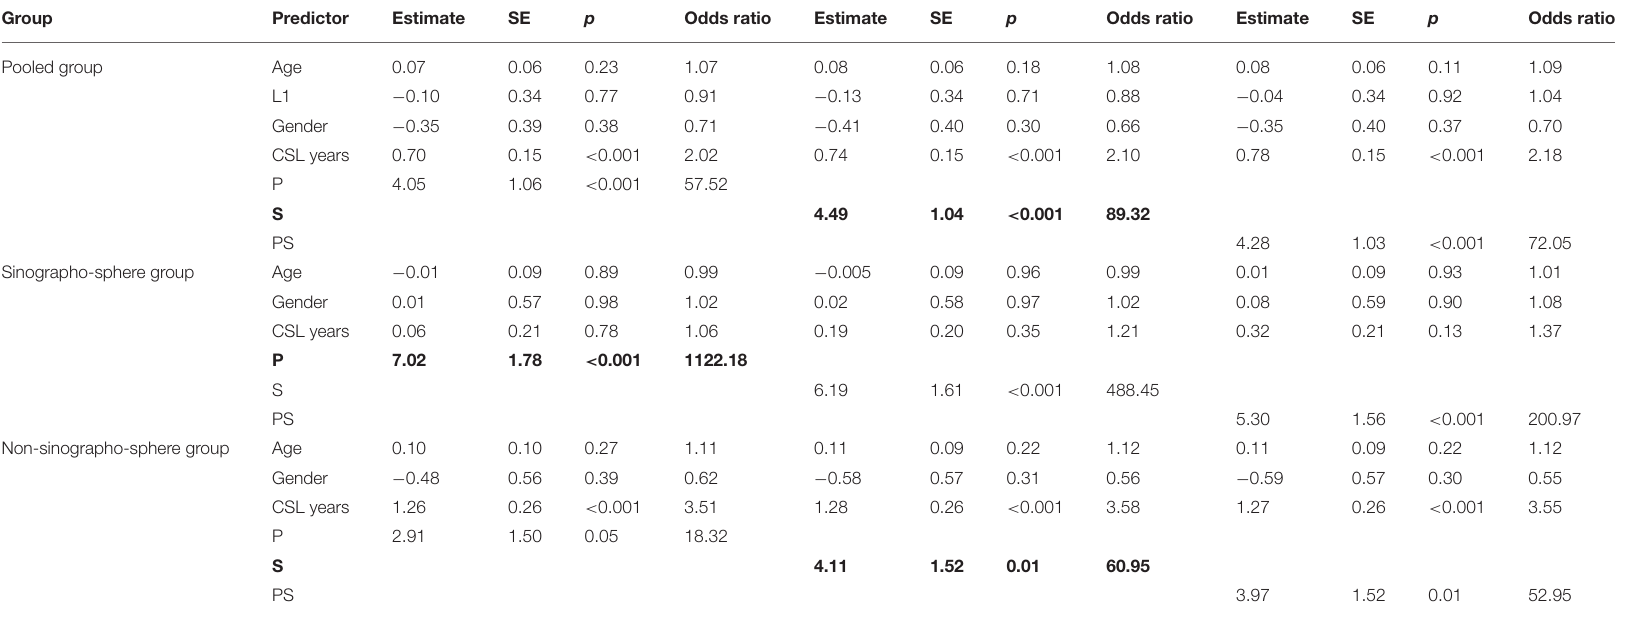
TABLE 10 | Summary of the predictive power of three methods in Chinese language proficiency.